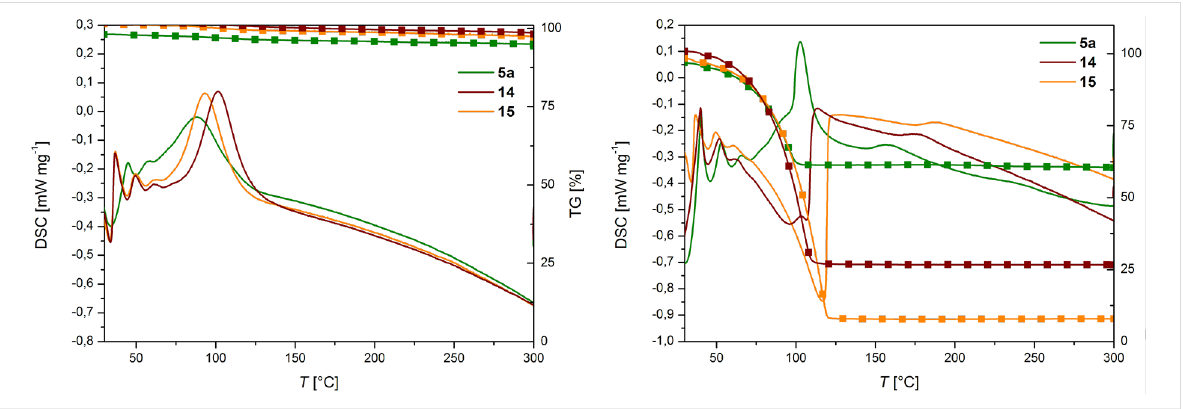
Figure 9: STA analysis of polymerization of 22 (left) and 23 (right), initiated by 5a , 14 and 15 . Reaction conditions: [ 22 ]:[initiator] = 500 and [ 23 ]:[initiator] = 10000:1. Heating rate: 3 K/min. Big symbols: thermogravimetric analysis (TGA); no symbols: differential scanning calorimetry (DSC).